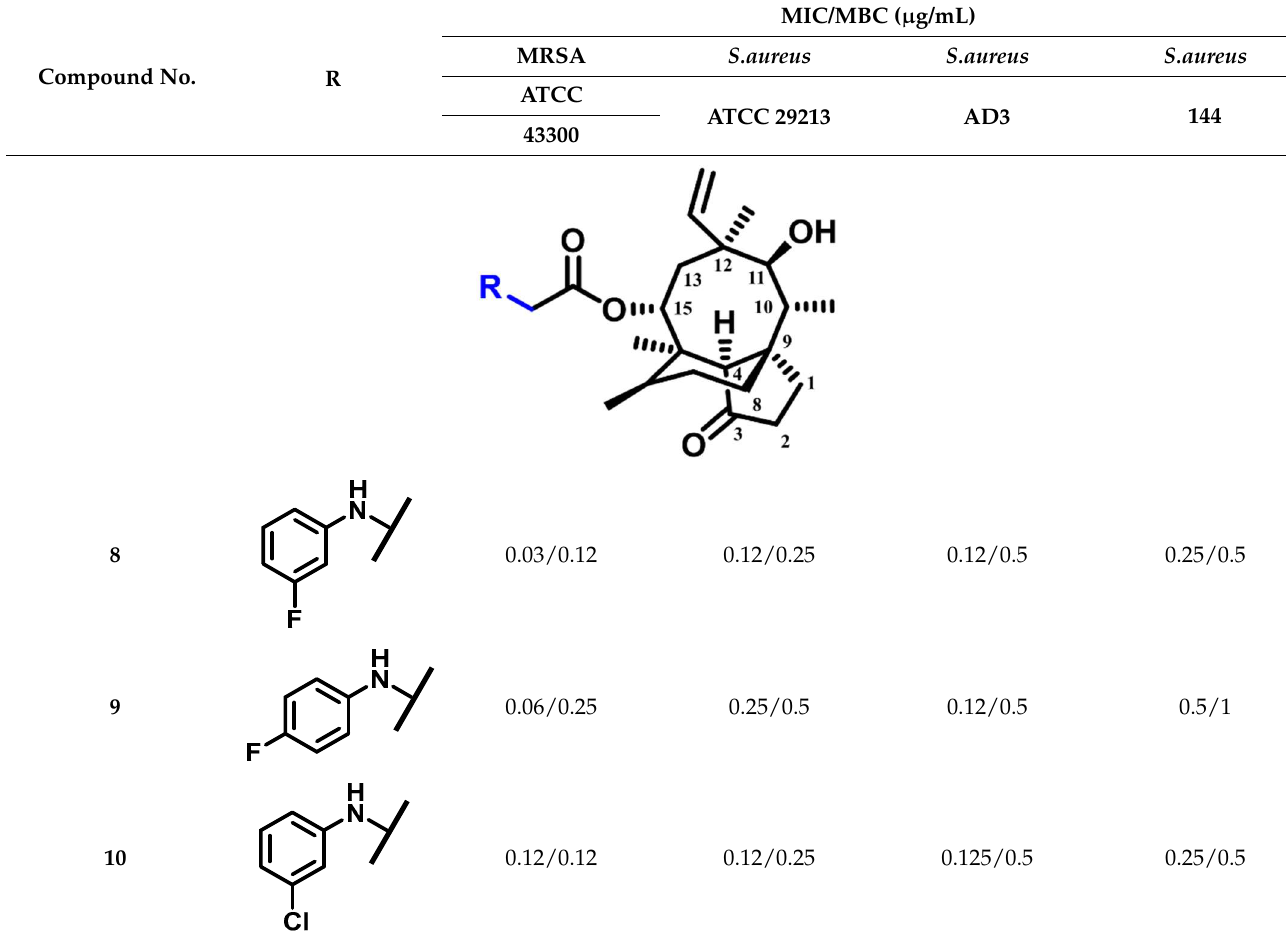
Table 1. MIC and MBC ( µ g/mL) values of compounds 8 – 30 , tiamulin against S. aureus (ATCC 43300), Table 1. MIC and MBC ( μ g/mL) values of compounds 8 – 30 , tiamulin against S. aureus (ATCC Table 1. MIC and MBC ( μ g/mL) values of compounds 8 – 30 , tiamulin against S. aureus (ATCC Table 1. MIC and MBC ( μ g/mL) values of compounds 8 – 30 , tiamulin against S. aureus (ATCC Table 1. MIC and MBC ( μ g/mL) values of compounds 8 – 30 , tiamulin against S. aureus